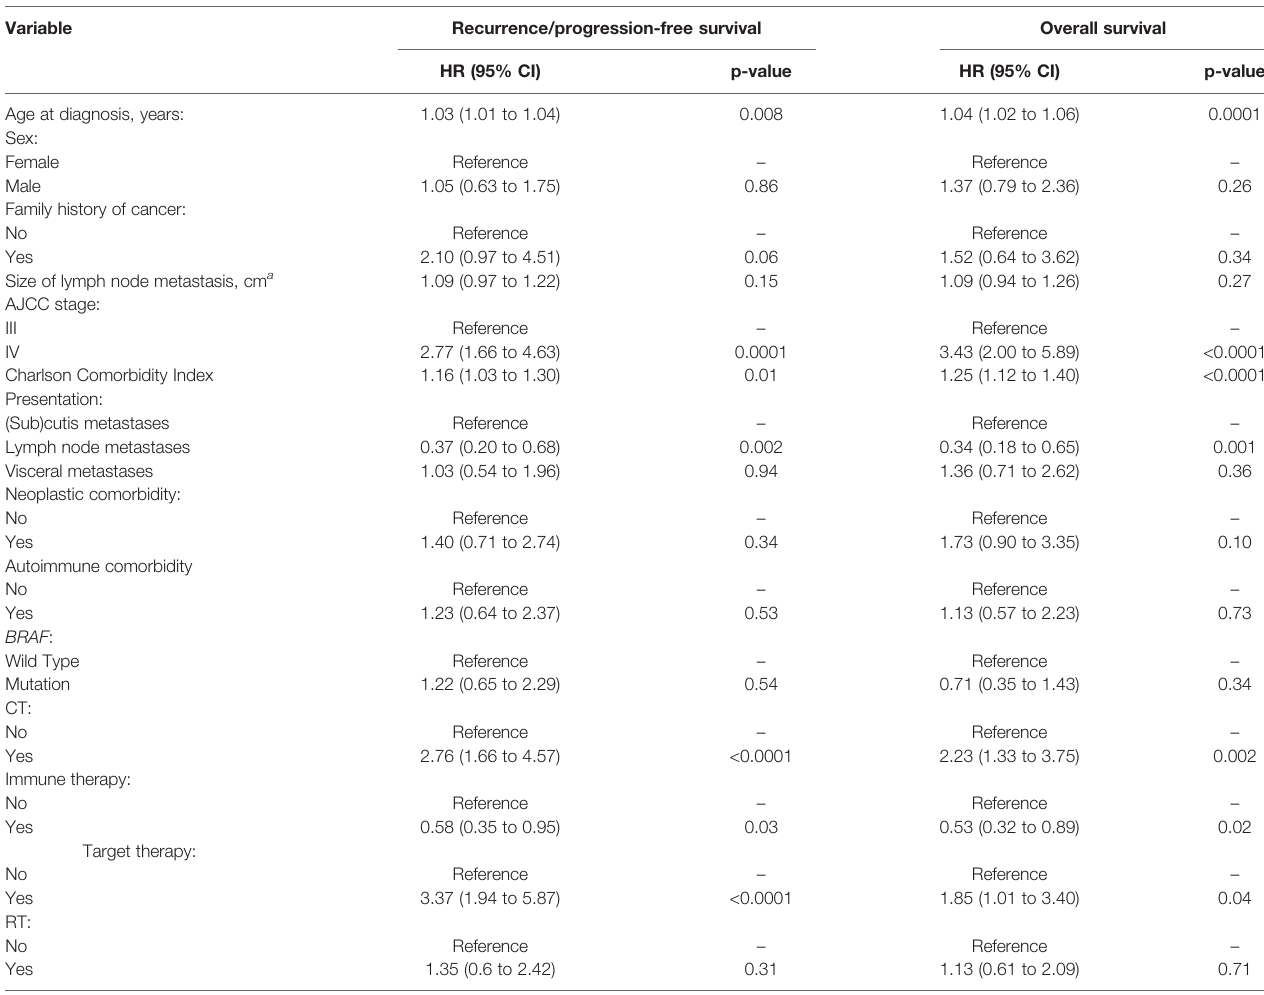
TABLE 3 | Univariate analysis of survival.